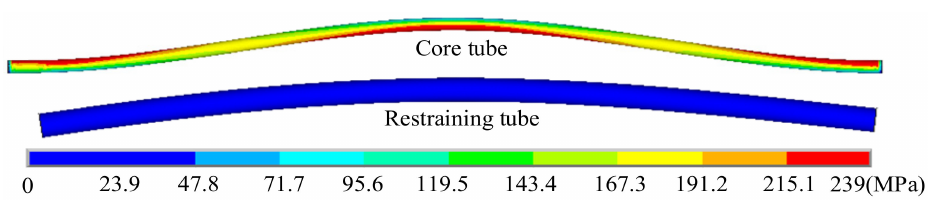
Figure 18. Full-range analysis of a member with global buckling: ( a ) P - ∆ relationships; ( b ) P - v m relationships.